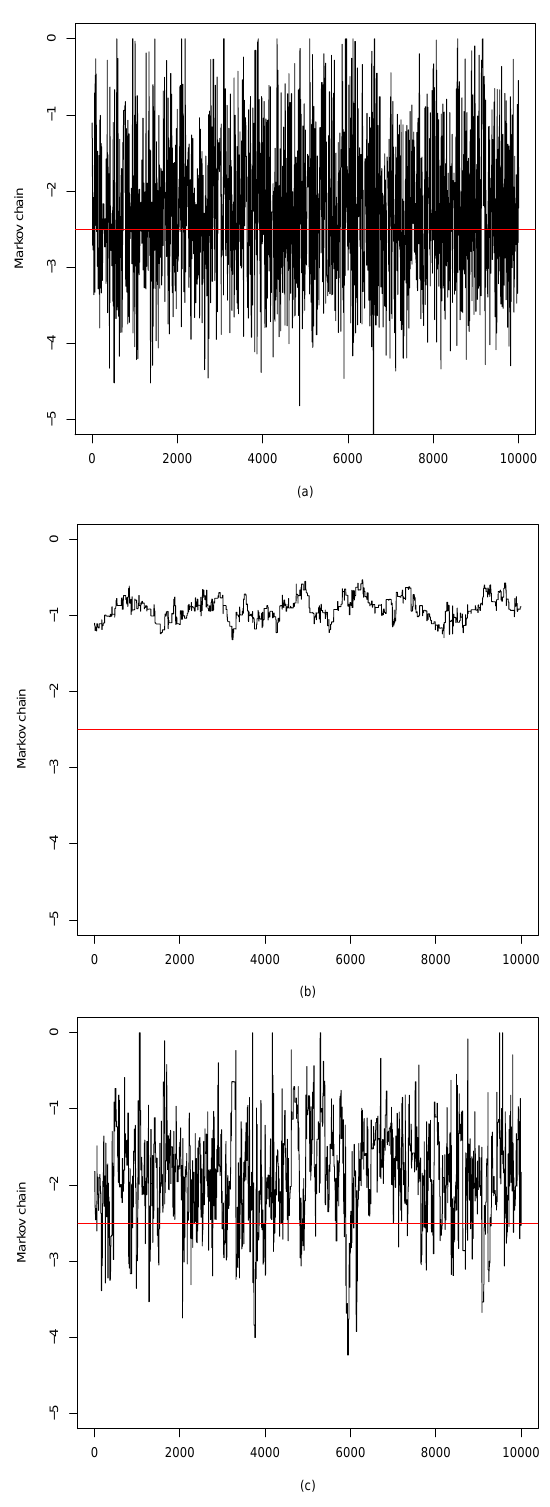
Figure 9. The Markov chain of ˜ a 1 via using ( a ) domain I, ( b ) domain II, and ( c ) domain III: The straight line is the true value of a 1